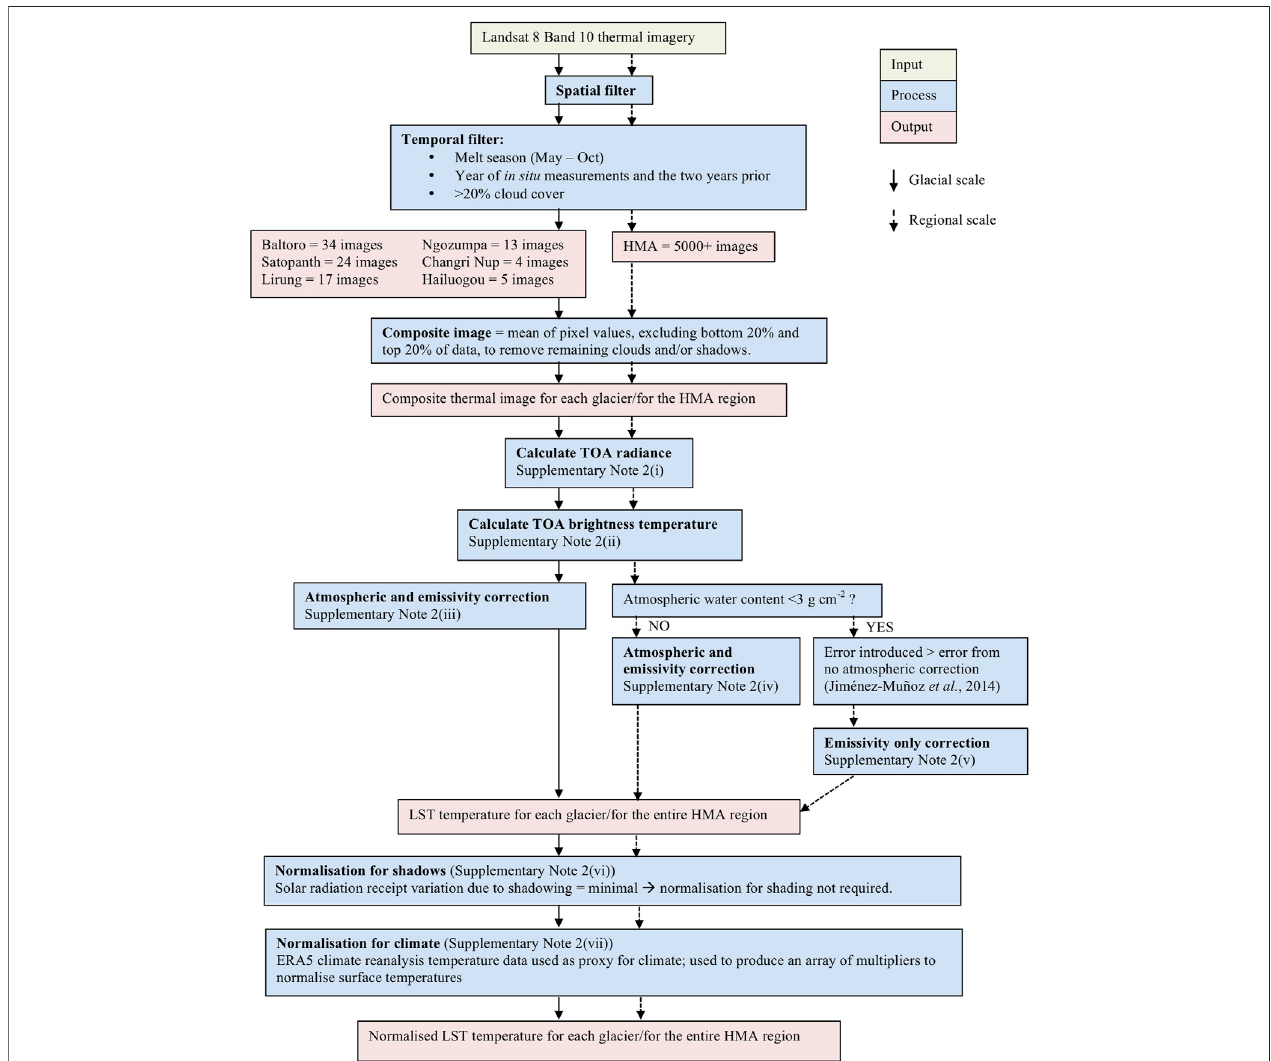
FIGURE 3 | Flowchart of methodology to calculate and normalise Land Surface Temperature from Landsat 8 thermal band imagery, within Google Earth Engine.